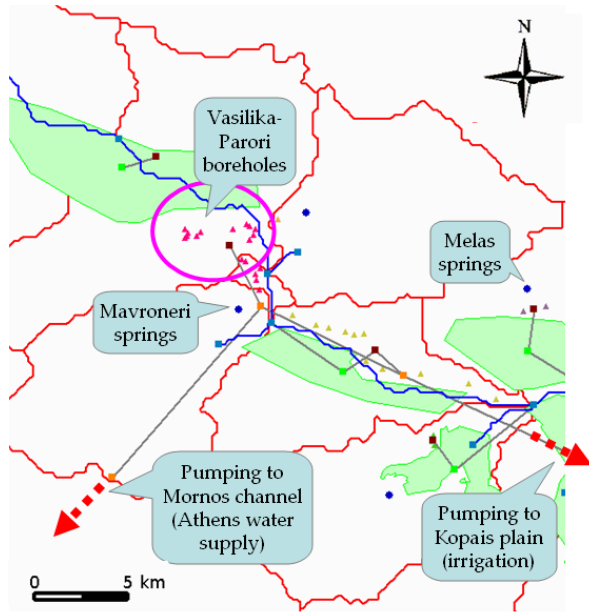
Fig. 5. Detailed depiction of the water management network in the middle part of the basin, according to modelling framework